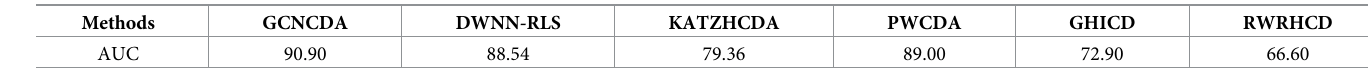
Table 4. The 5-fold CV AUC scores generated by the various models on the same benchmark dataset circR2Disease. Methods